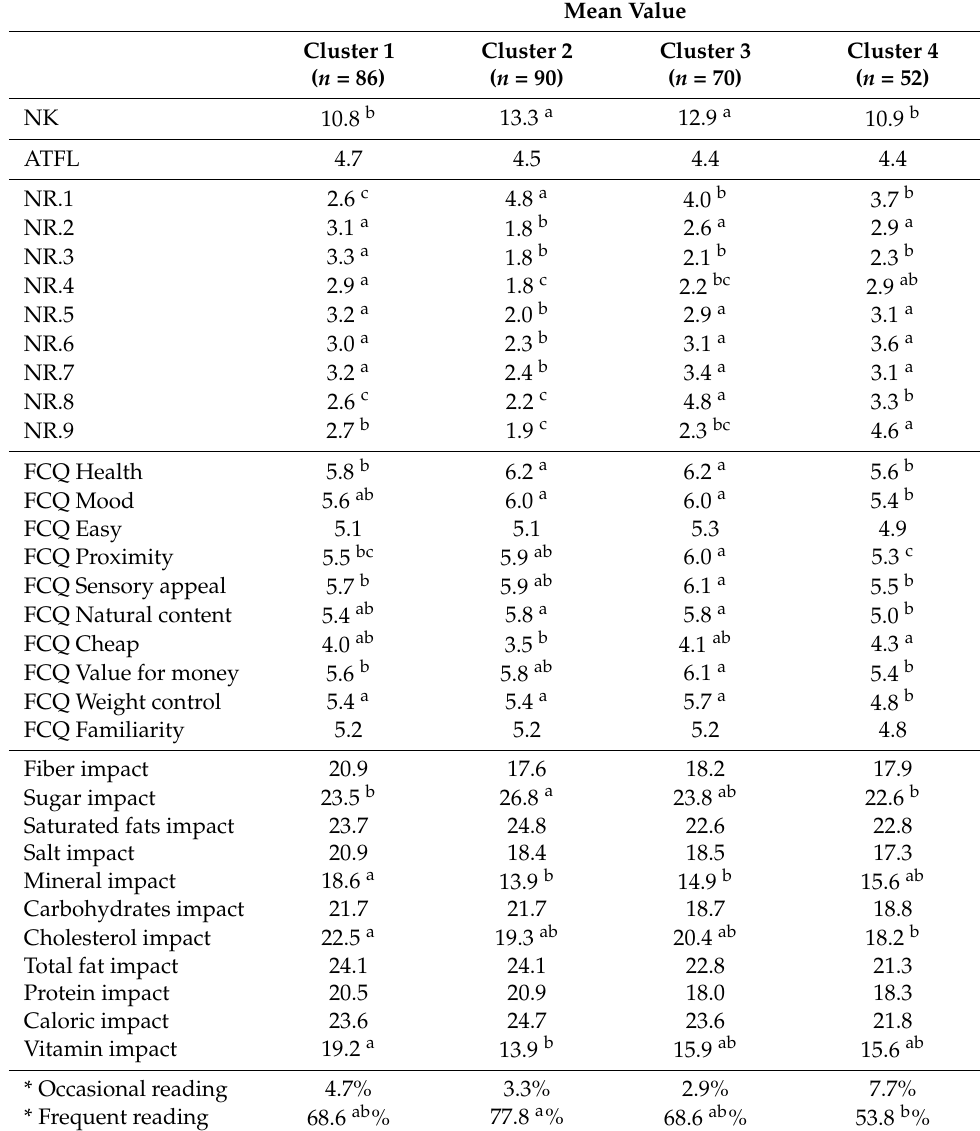
Table 5. Mean values per cluster of the different items or constructs assessed in the questionnaire and label reading percentages for the participants who followed a